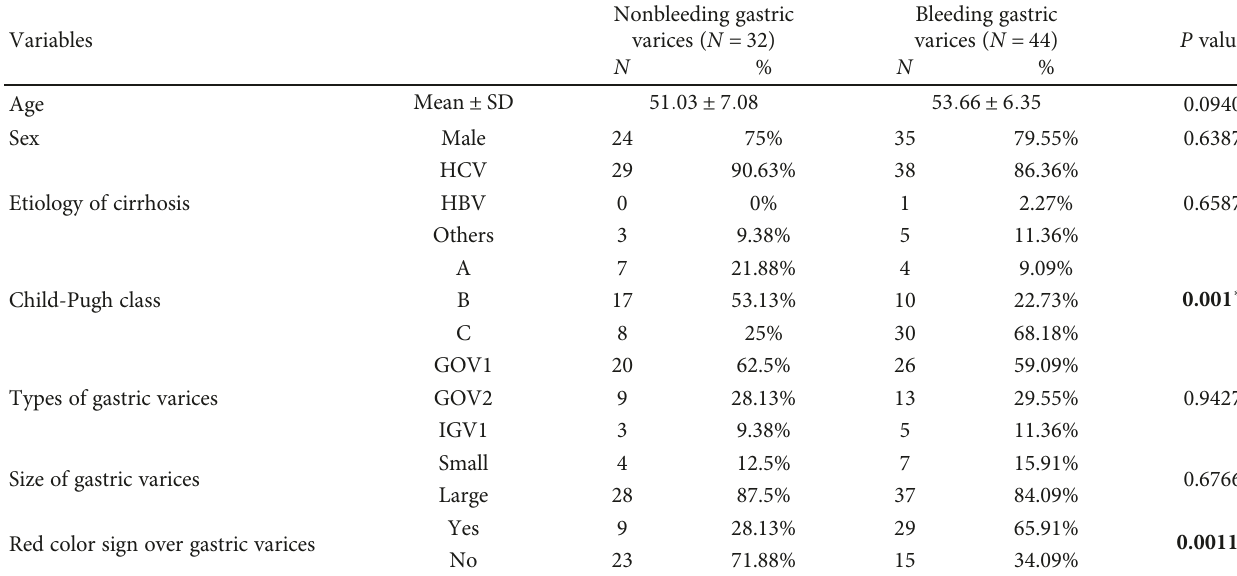
Table 1: Demographic data and endoscopic fi ndings of gastric varices in the studied patients.